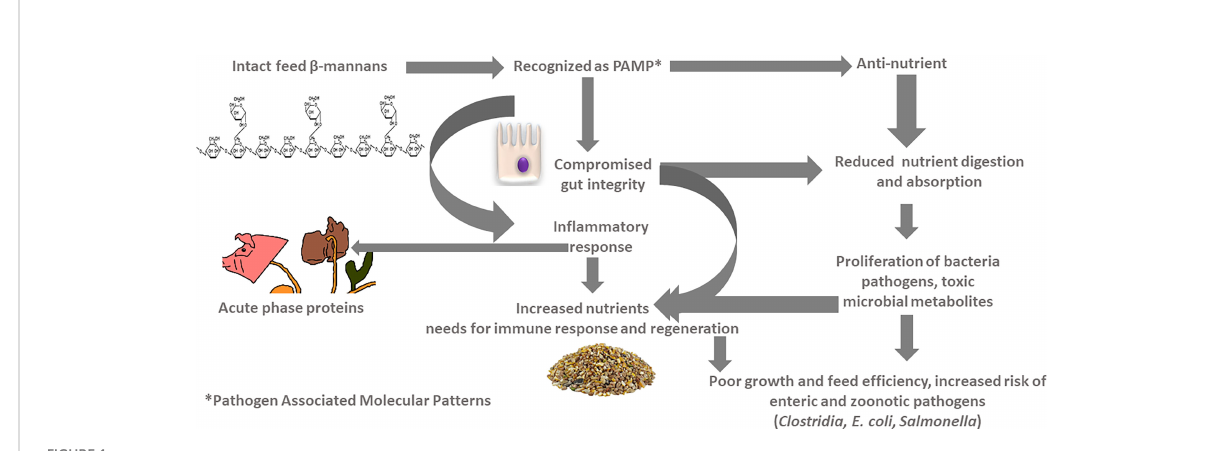
FIGURE 1 Framework for implications of feed b -mannans on gastrointestinal physiology and